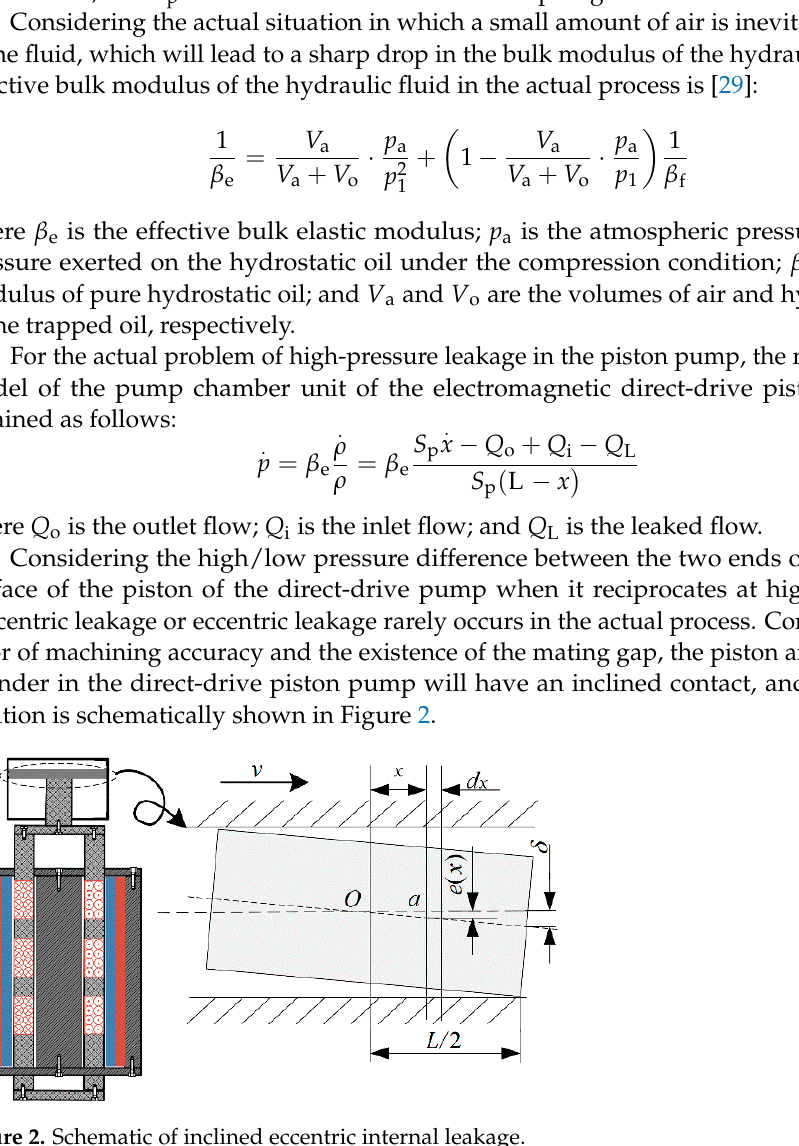
Figure 2. Schematic of inclined eccentric internal leakage.